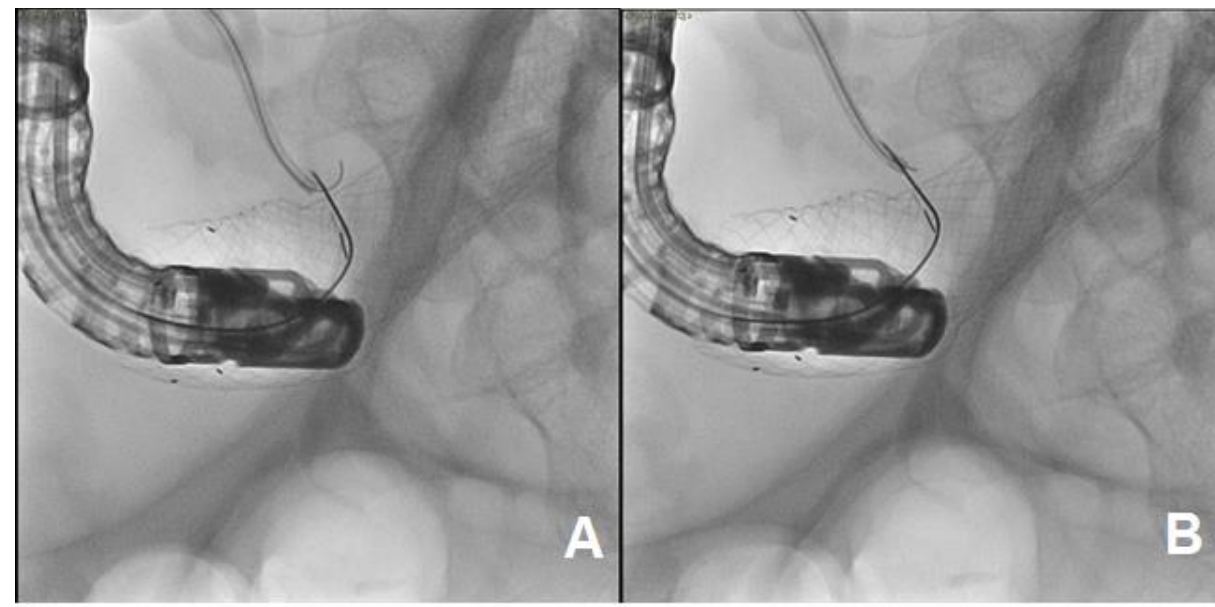
Figure 6. PTC. ( A ) On the left, the Teflon-coated guidewire that goes beyond the major papilla. ( B ) On the right, a guidewire was inserted through the sphincterotome and reached the main bile duct, overcoming the major papilla.